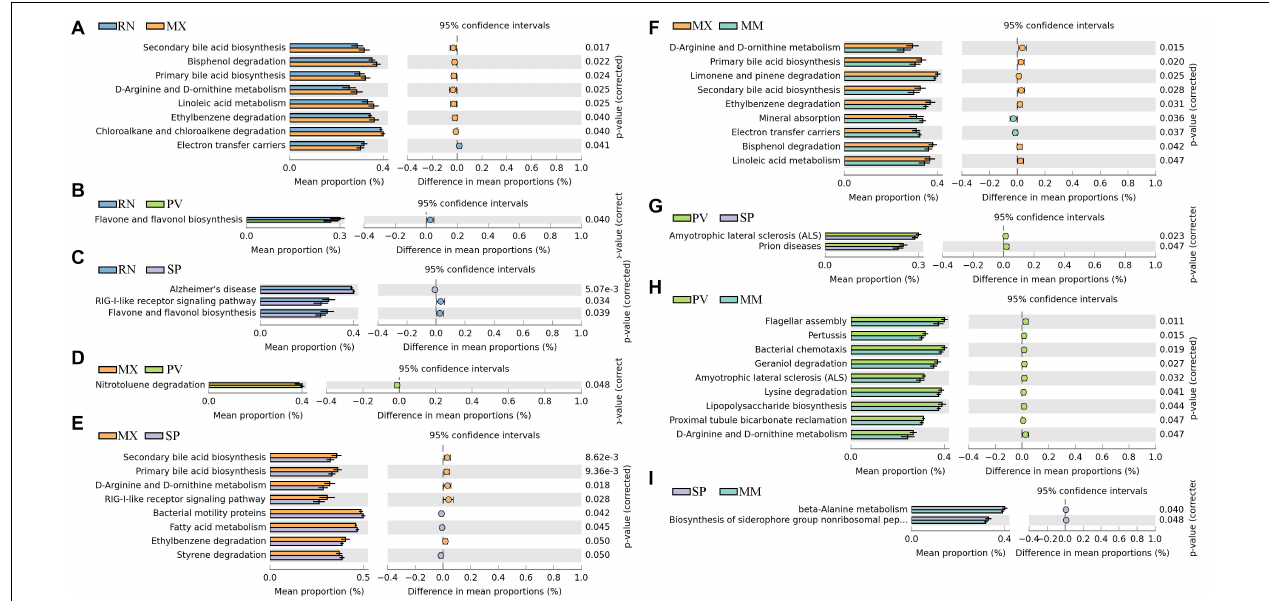
FIGURE 3 | Significant differences in microbial metabolic pathways at ring-necked pheasant (RN), manchurian pheasant (MX), phasianus versicolor (PV), Shenhong pheasant (SP), and melanistic mutant pheasant (MM). (A) RN versus MX. (B) RN versus PV. (C) RN versus SP. (D) MX versus PV. (E) MX versus SP. (F) MX versus MM. (G) PV versus SP. (H) PV versus MM. (I) SP versus